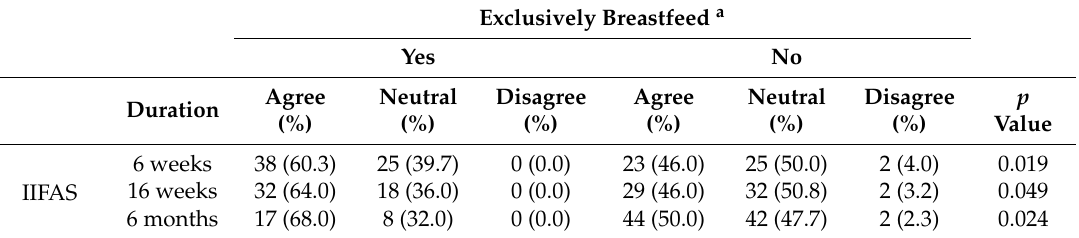
Table 5. Assessment of validity of IIFAS-S total scores by duration of breastfeeding. The relationship between the duration of breastfeeding and the IIFAS total scores was examined. IIFAS total score was significantly associated with exclusive breastfeeding at 6 and 12 weeks and 6 months postpartum.